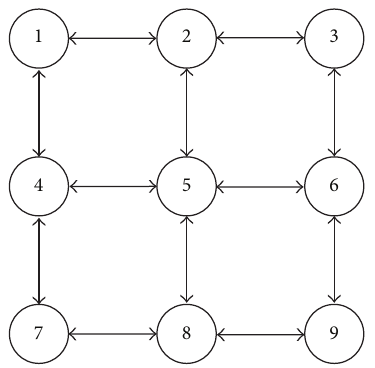
Figure 5: Directed graph expressing couplings.